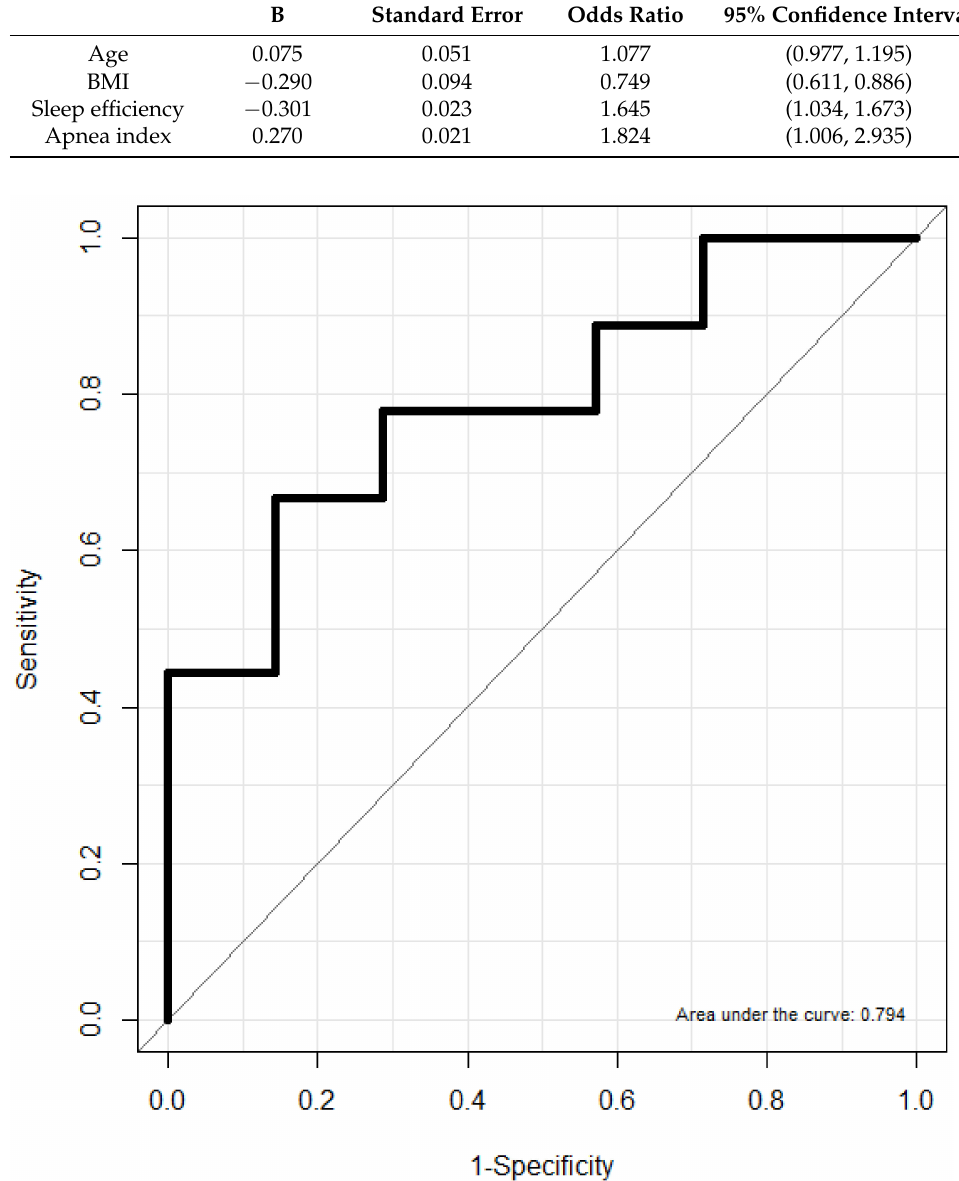
Figure 1. Receiver operating characteristic curve (ROC) for prediction of cognitive impairment using BMI, sleep efficiency and apnea